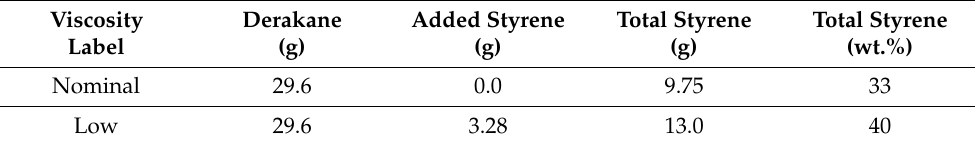
Table 2. Masses used in the experiments of modified viscosity (by adding styrene monomer).